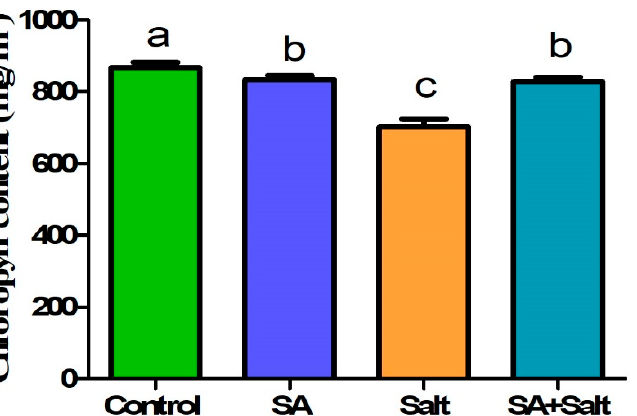
Figure 3. Impact of salicylic acid on chlorophyll content of St. John’s under normal and salinity stress conditions. Treatments: control, SA (0.25 mM salicylic acid), salt (150 mM NaCl), SA (0.25 mM sali ‐ cylic acid) + salt (150 mM NaCl). Each value represents the mean ± SD ( n = 10). Different letters on each bar represent statistically significant differences as evaluated by DMRT and t ‐ test at p ≤